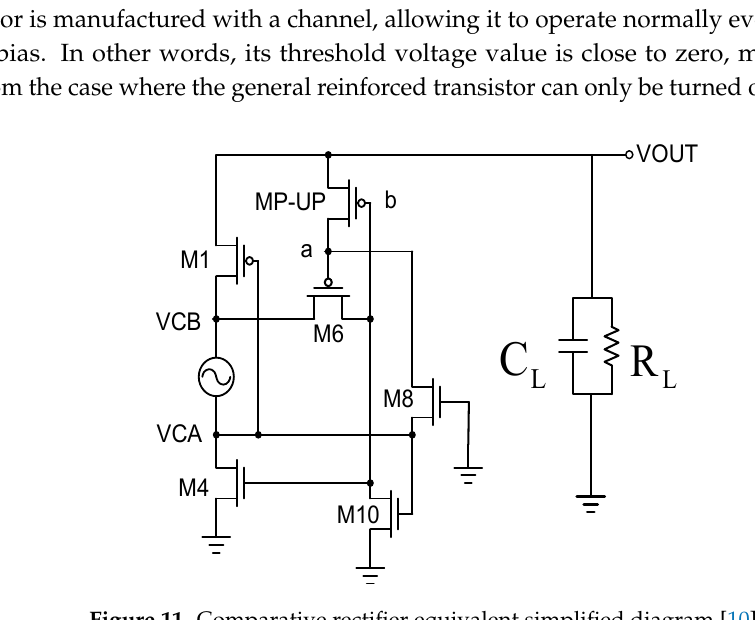
Figure 12. Simulation of voltage vs. time during a cycle. Table 1. Rectifier Switching State during Cycle. M1